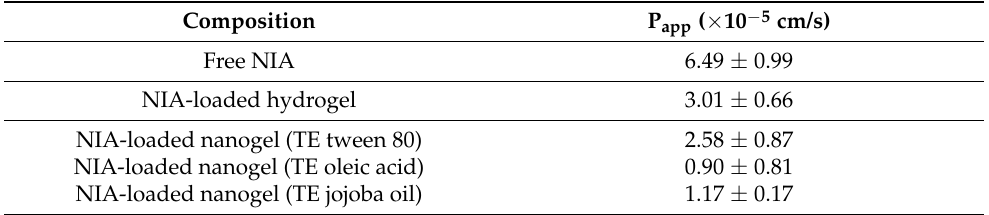
Table 4. Apparent permeability coefficient of free NIA and NIA-loaded hydrogels and